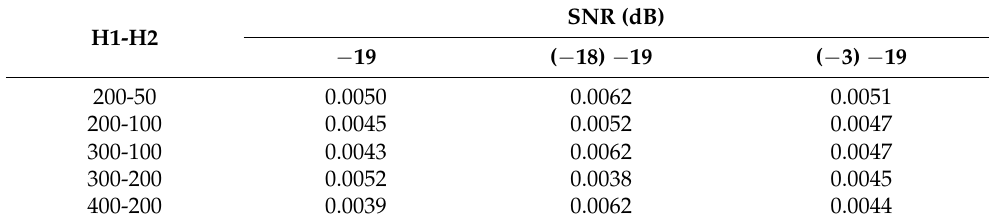
Table 1. SER comparison based on two hidden layers in the stacked DSAE network.